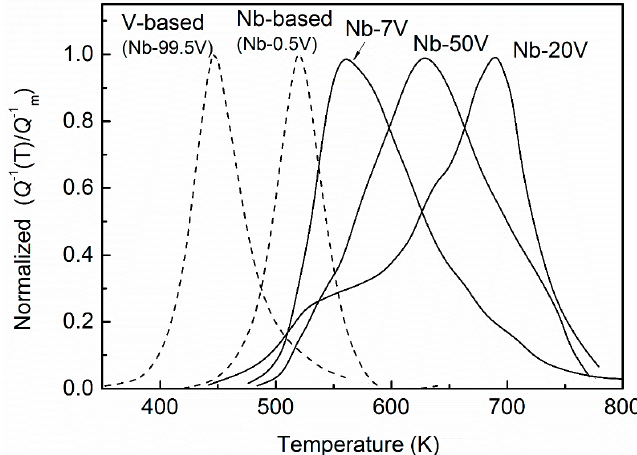
Figure 13. Normalized relaxation peaks for concentrated substitutional solute Nb–V alloys with 7, 20, and 50 at. % V. Comparison with the peaks for Nb-based (Nb–0.5V (at. %)) and V-based (Nb–99.5V (at. %)) systems.